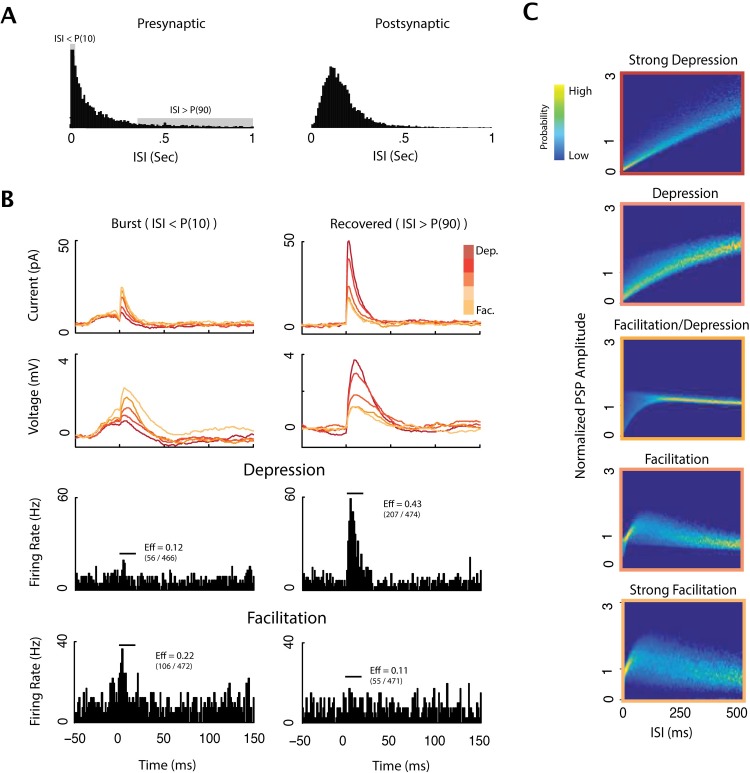
Postsynaptic responses for different presynaptic ISIs reveal the effects of STP.A) Inter-spike interval (ISI) distribution of a presynaptic and the postsynaptic neuron B) PSCs and PSPs [top] for strongest excitatory synapses for five different types of plasticity (colors) separated by presynaptic ISI (<10th percentile, left; >90th percentile, right). Depressing synapses have much larger PSC/PSPs for ISIs >90th percentile, while facilitating synapses have larger PSC/PSPs for the ISIs <10th percentile. Postsynaptic spiking [bottom] shows similar effects, but tend to be much more difficult to interpret due to the sparse spike responses. Split cross-correlograms are shown for two synapses: one with strong depression and one with strong facilitation [bottom]. For comparison, the PSPs and PSCs are vertically offset such that the average from -50ms to -30ms was set to 0. C) The distribution of PSP amplitudes as a function of presynaptic ISI for the different classes of plasticity used in experiment. One reason that split cross-correlograms are difficult to interpret is that there is no deterministic relationship between ISI and PSP amplitude, and, in some cases, such as with facilitating synapses, the relationship is nonlinear.